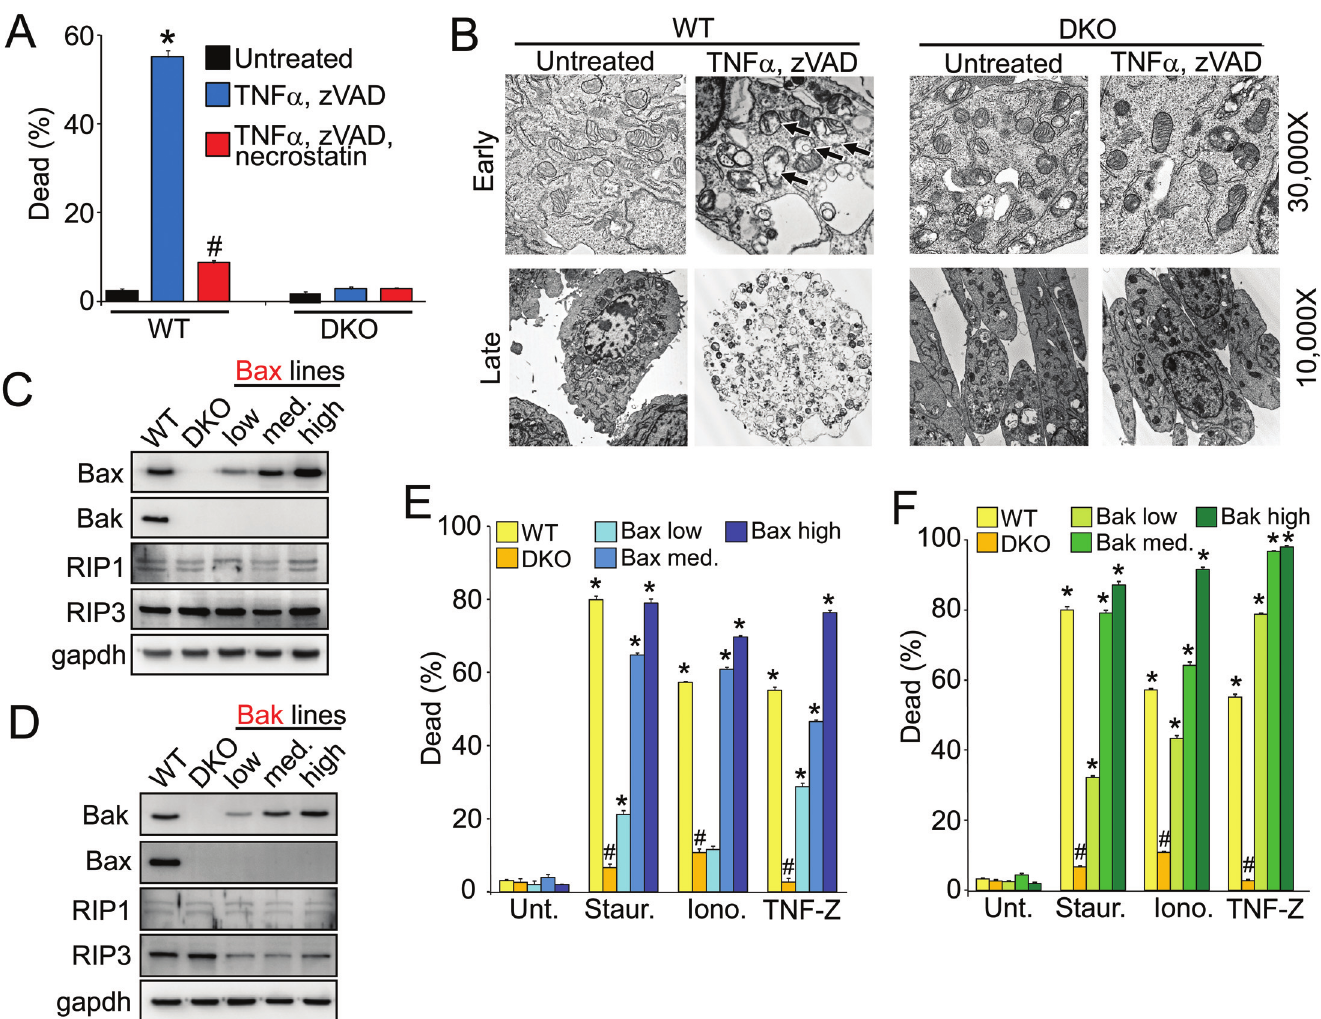
Fig 1. Bax and Bak are required for necroptosis. A, WT and Bax/Bak1 DKO MEFs treated with TNF α and zVAD-FMK with and without necrostatin. Dead cells (cells with permeabilized membranes) were labeled with the Muse Count & Viability assay and were quantitated using a Muse Cell Analyzer. B, Transmission electron microscopy of WT and DKO MEFs treated with and without TNF α and zVAD-FMK for 2 hours (Early) and 12 hours (Late). Arrows show unhealthy mitochondria. Magnification used is shown. C, D, Western blots for Bax, Bak, RIP1, RIP3, and gapdh (control) from extracts of WT, DKO, and clonal DKO MEFs stably expressing Bax (C) or Bak (D). E, F, Cell death in WT, DKO, and clonal DKO MEFs stably expressing Bax (E) or Bak (F) treated with apoptotic inducer staurosporine (Staur.), necrotic inducer ionomycin (Iono.) or necroptotic inducer TNF α and zVAD-FMK (TNF-Z). All assays were performed in duplicate and averaged from three independent experiments. * p < 0.01 vs. untreated; # p < 0.01 vs. WT